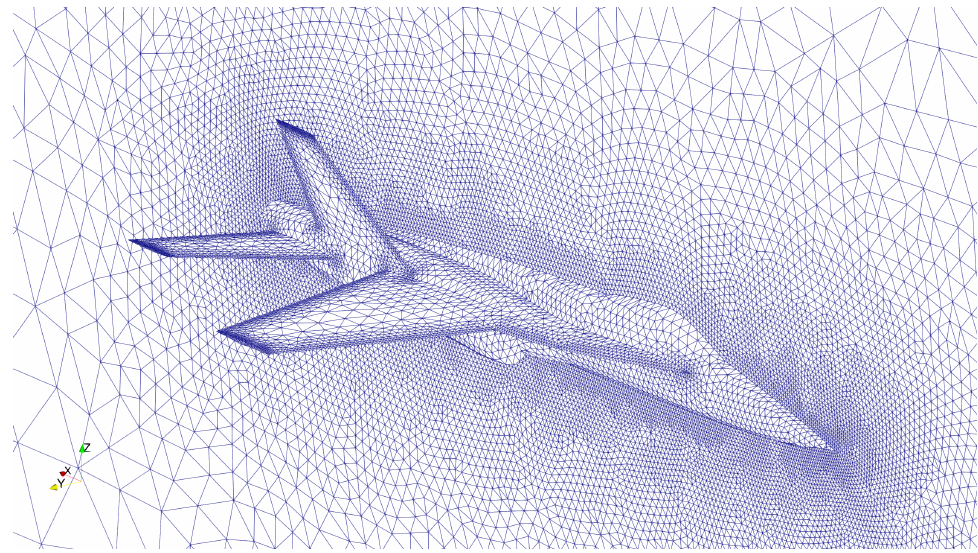
Figure 20. A zoomed-in view of the most important boundaries of the mesh for solving prob- lems in Section